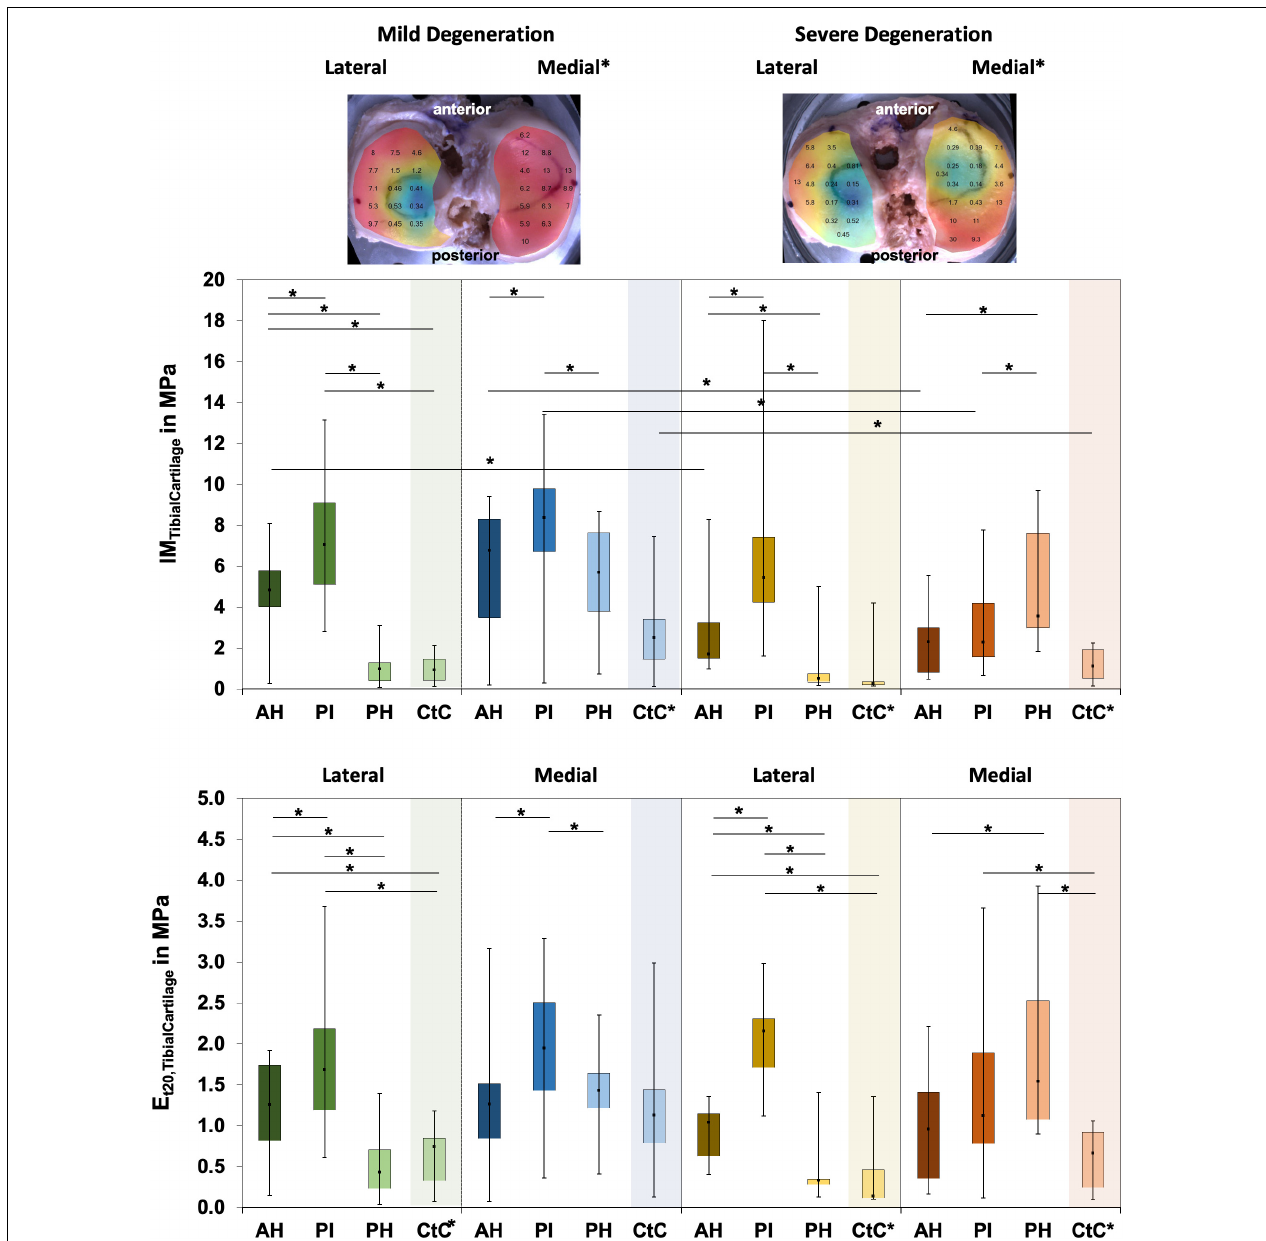
FIGURE 5 | Representative biomechanical mappings of the instantaneous modulus (IM) measurements of the mildly and severely degenerated tibial plateau articular cartilage (AC), with all values given in megapascal. Middle row : Box plots (minimum, maximum, median, and 25th and 75th percentiles) of the lateral and medial IM TibialCartilage values in megapascal. Lower row : Box plots (minimum, maximum, median, and 25th and 75th percentiles) of the lateral and medial E t20 values in megapascal. Subdivided anatomical regions are: AH , anterior horn; PI , pars intermedia; PH , posterior horn; CtC , cartilage-to-cartilage contact area. Non-parametric statistical analyses: n = 12; * p < 0.05. For reasons of readability, we marked significant differences between the mild and severe degeneration of the medial and lateral sides above the representative biomechanical mappings and also between the CtC and other anatomical compartments only at the legend of the category axis (e.g.,